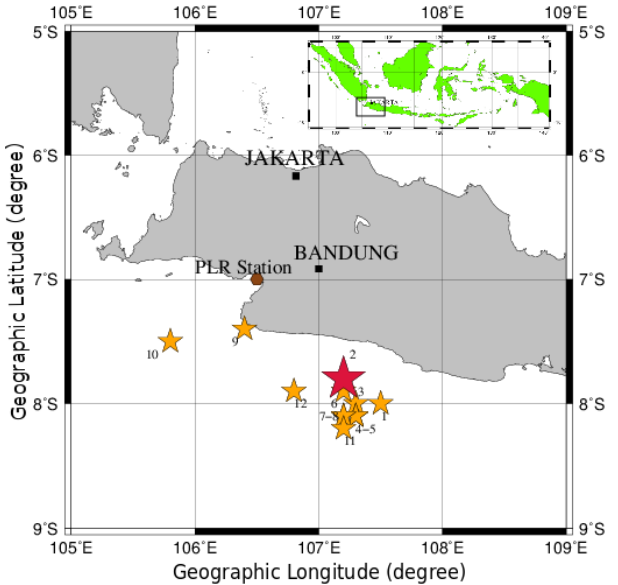
Fig. 3. Map of the ULF station (PLR) and EQ epicenters occurred during the analyzed period. The red star indicates the main shock (2 September 2009) and orange stars present other EQs in Table 1.